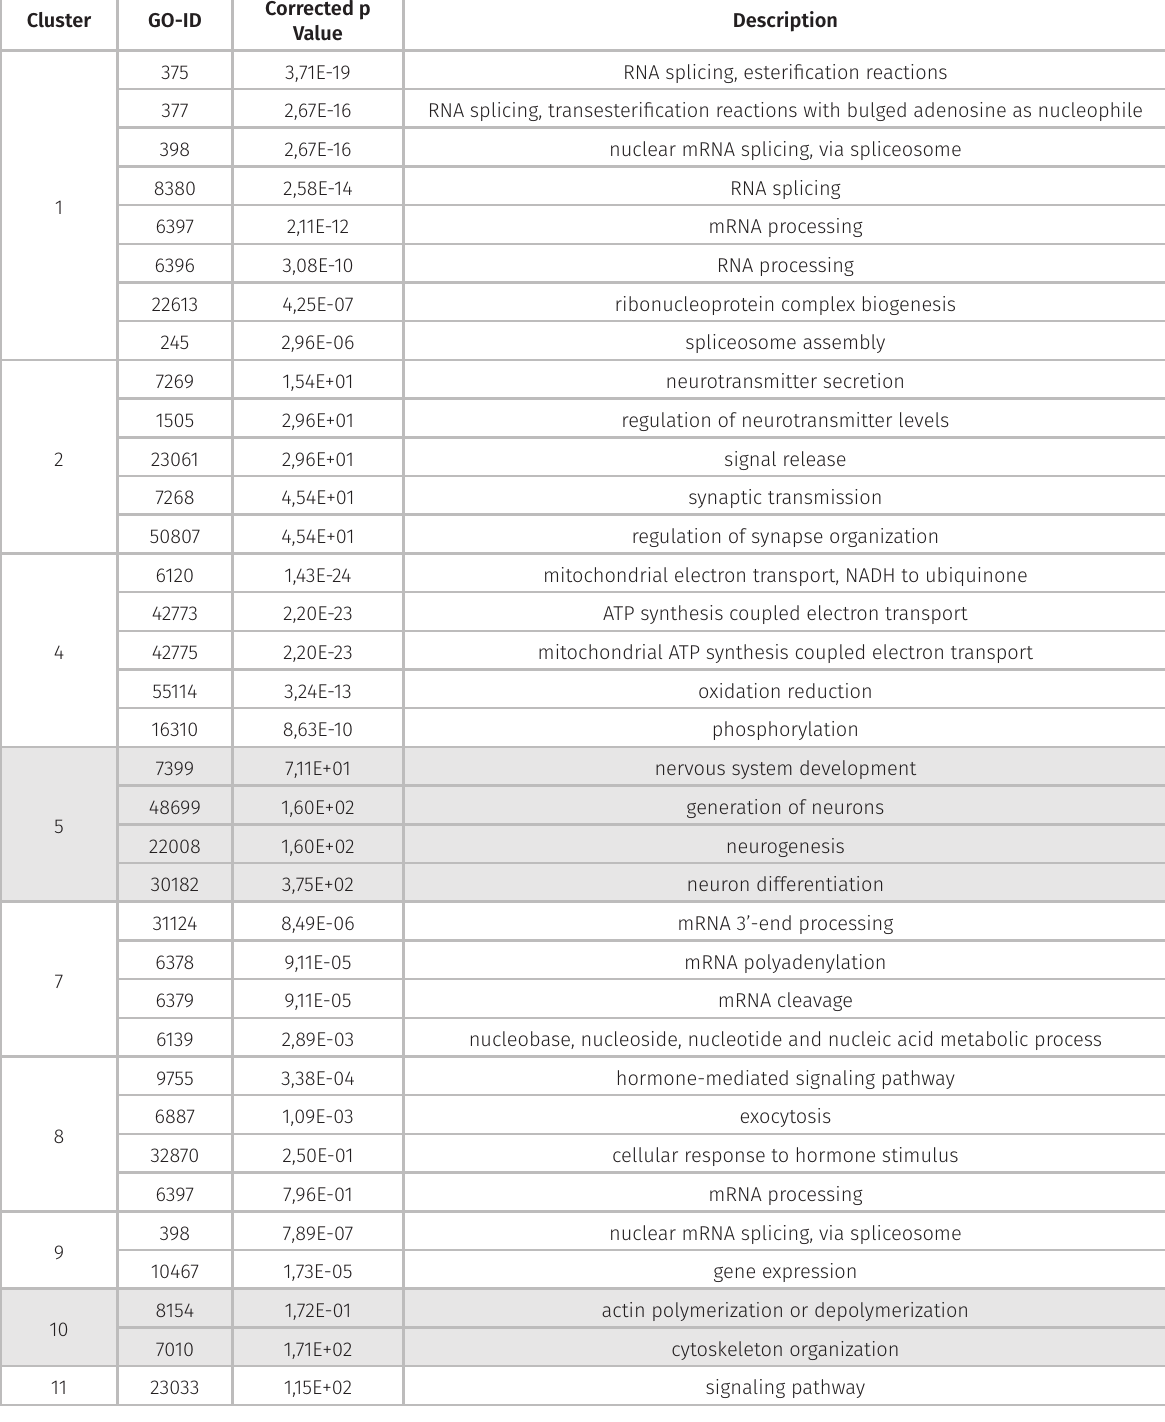
Table I. Specific gene ontology classes derived from protein-protein interactions within compound-protein interaction